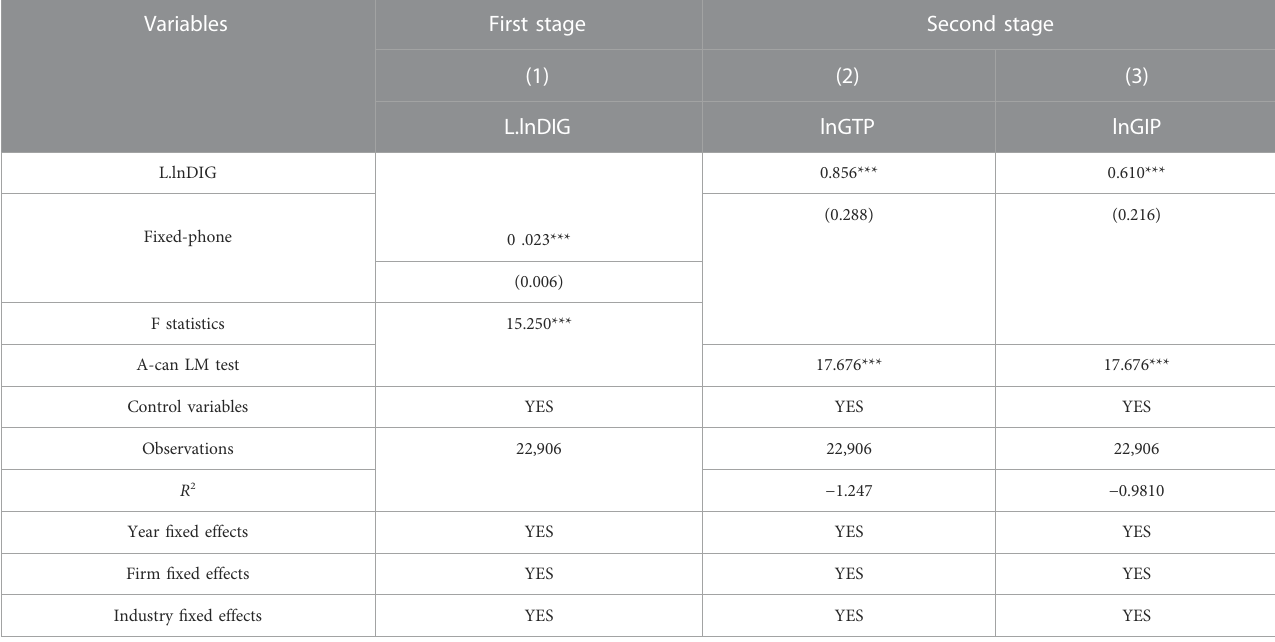
TABLE 8 Instrumental variable method. Variables First